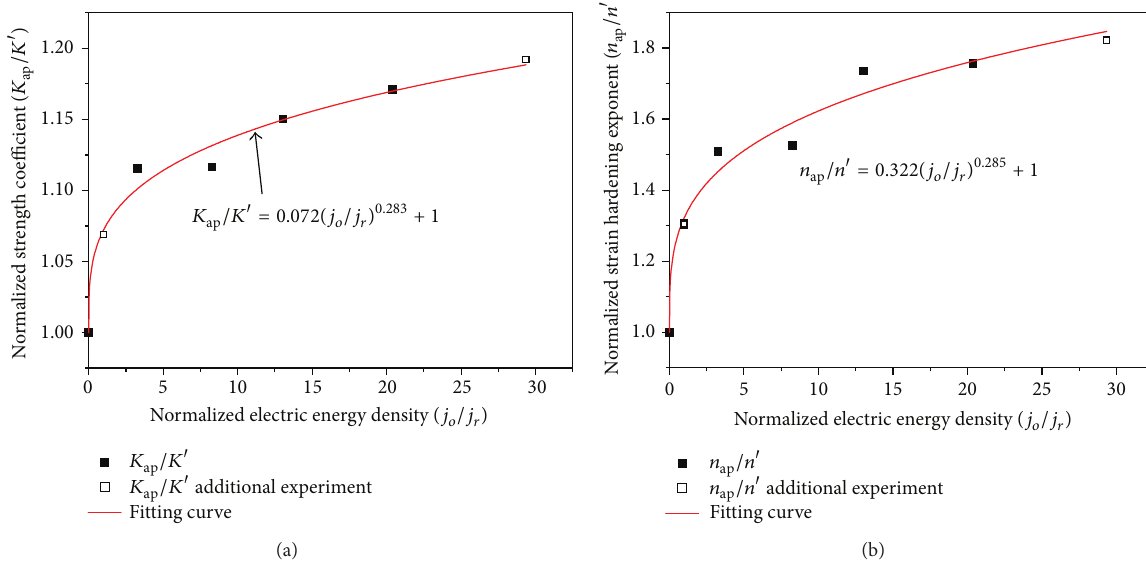
Figure 9: The normalized hardening parameters as functions of the electric energy density: (a) 𝐾 ap /𝐾 󸀠 and (b) 𝑛 ap /𝑛 󸀠 . Note that the results of additional experiments were plotted and after that the fitted curves were